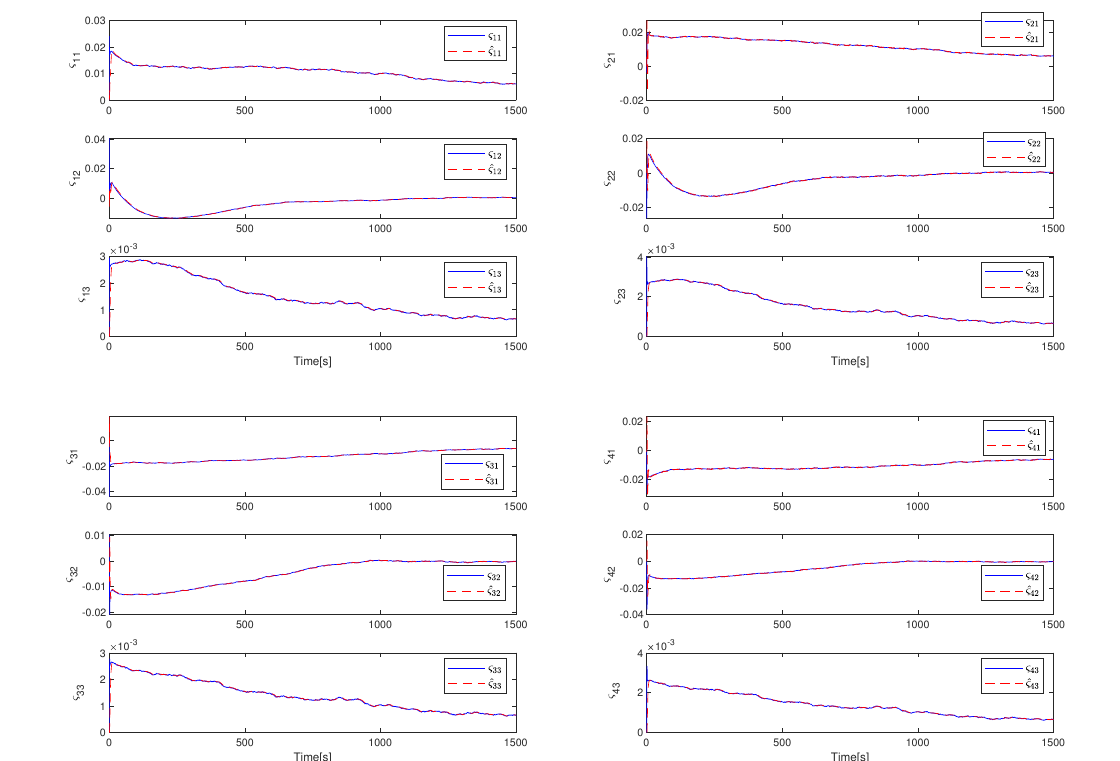
Figure 6. Lumped disturbances and estimations of four vessels.